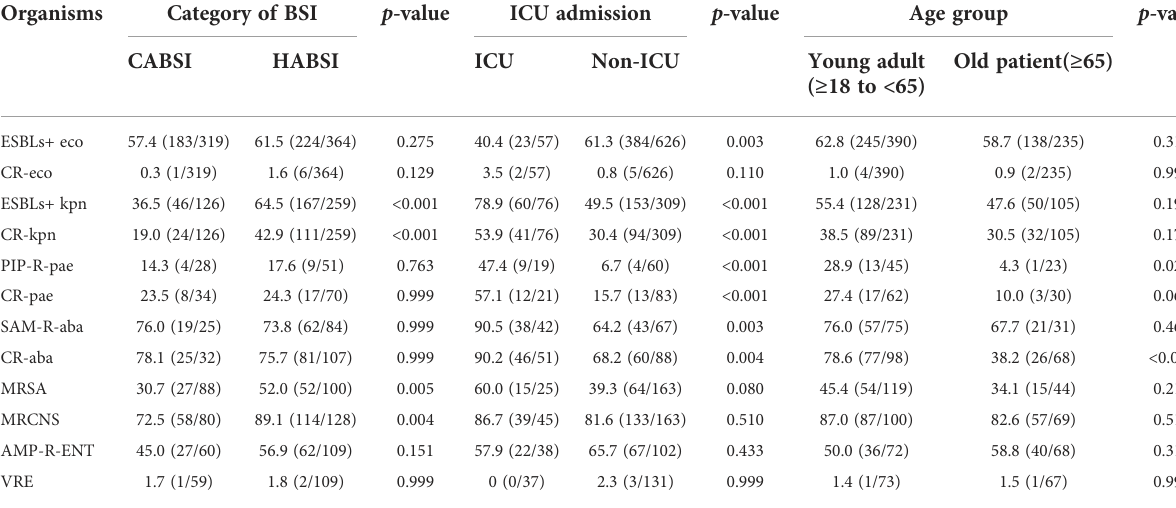
TABLE 8 Prevalence of important resistant pathogens isolated from bloodstream infections in different patient populations.